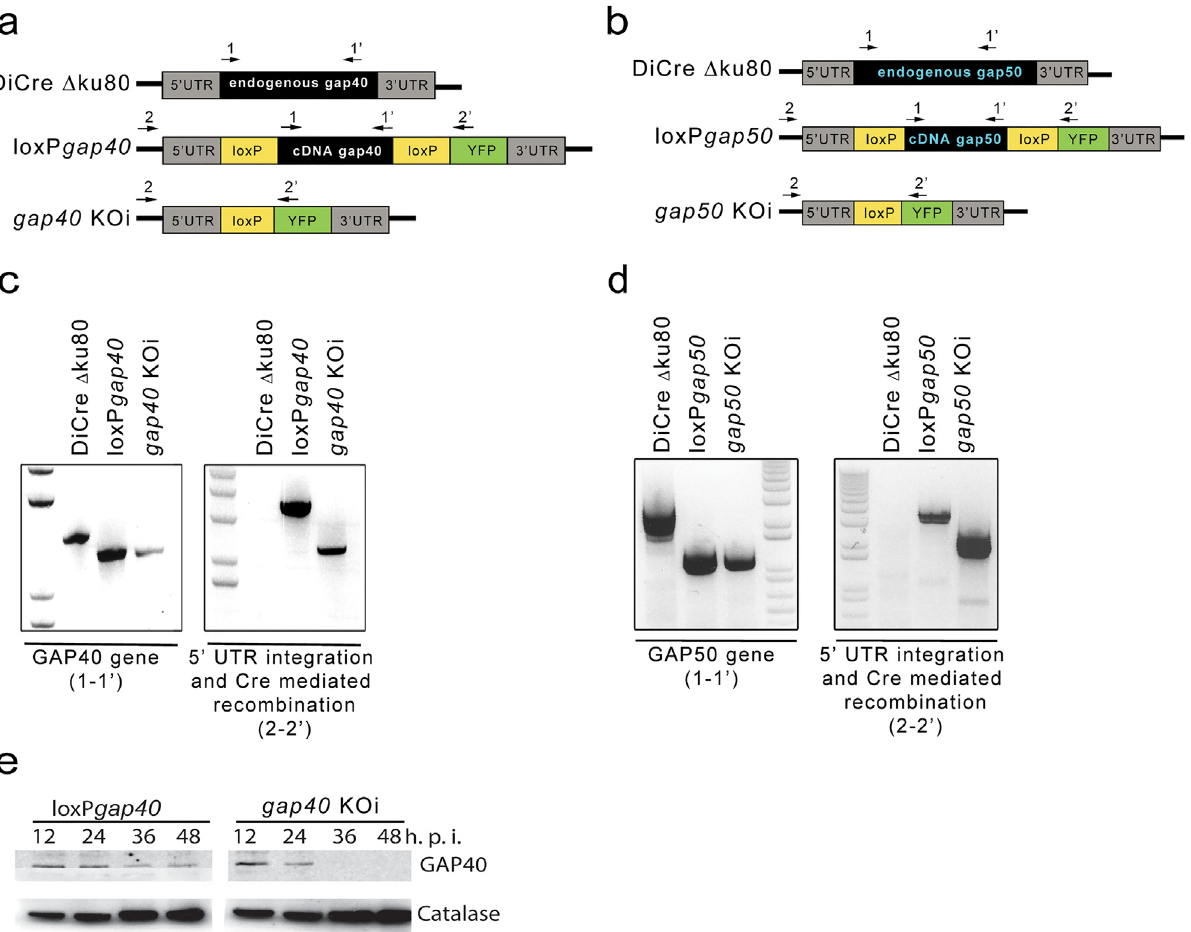
Fig 2. Strategy used and confirmation of integration of conditional deletion of gap40 and gap50 . Schematic indicating the strategy used to replace the endogenous gap40 ( a ) or gap50 ( b ) gene with the respective cDNA flanked by loxP sites. Arrows indicate location of oligonucleotides used for analytical PCRs. Integration PCRs demonstrating the correct integration of the gap40 ( c ) or gap50 ( d ) into the genome. Replacement of the endogenous gene with cDNA can be detected using primers (1 – 1 ’ ) while (2 – 2 ’ ) demonstrates correct 5 ’ integration (see Table 1) and Cre-mediated recombination. ( e ) 50 nM rapamycin was added to induce excision and parasites collected at indicated time points. Using a specific antibody, GAP40 levels are undetectable by 36 h post induction by western blot. Catalase was used as a loading control.